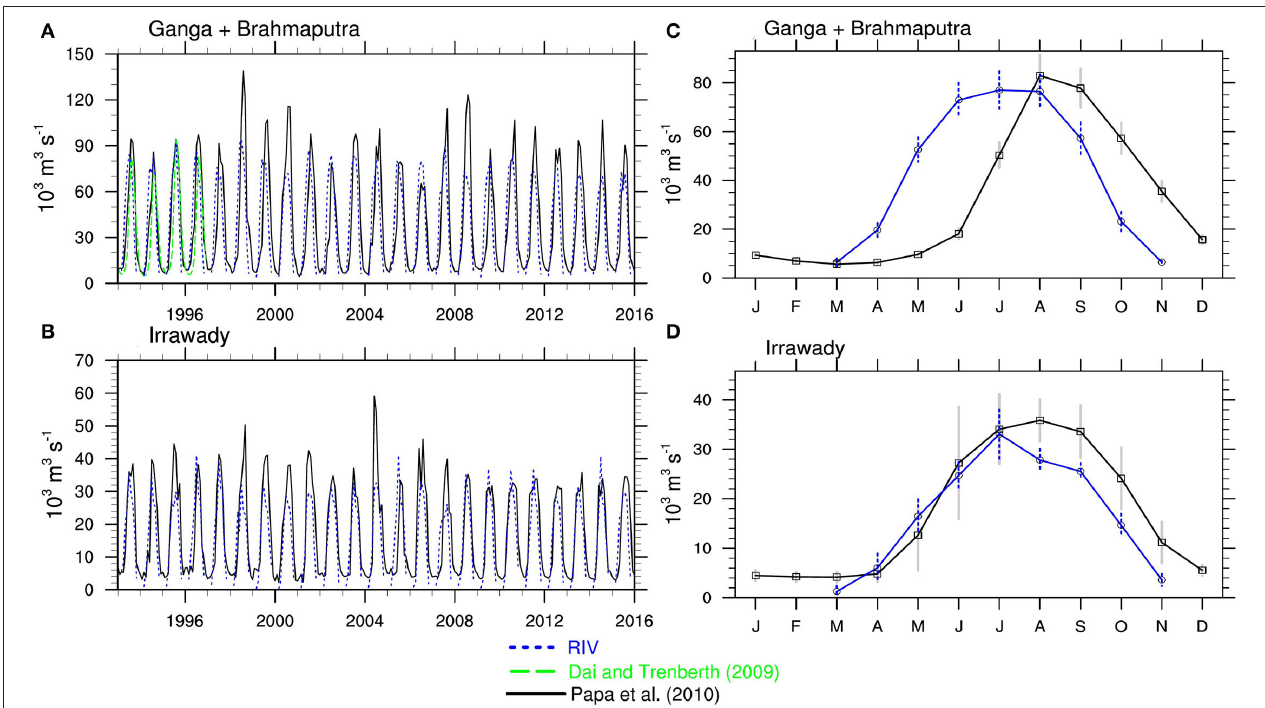
FIGURE 3 | Monthly mean hydrographs in observations and RIV simulations during the period 1993–2016 for (A) Ganga + Brahmaputra and (B) Irrawady. The climatological annual cycle of the hydrographs depicted in (A,B) for (C) Ganga + Brahmputra and (D) Irrawady. Also shown as vertical error bars is the inter-annual standard deviation of the monthly mean hydrographs for the period